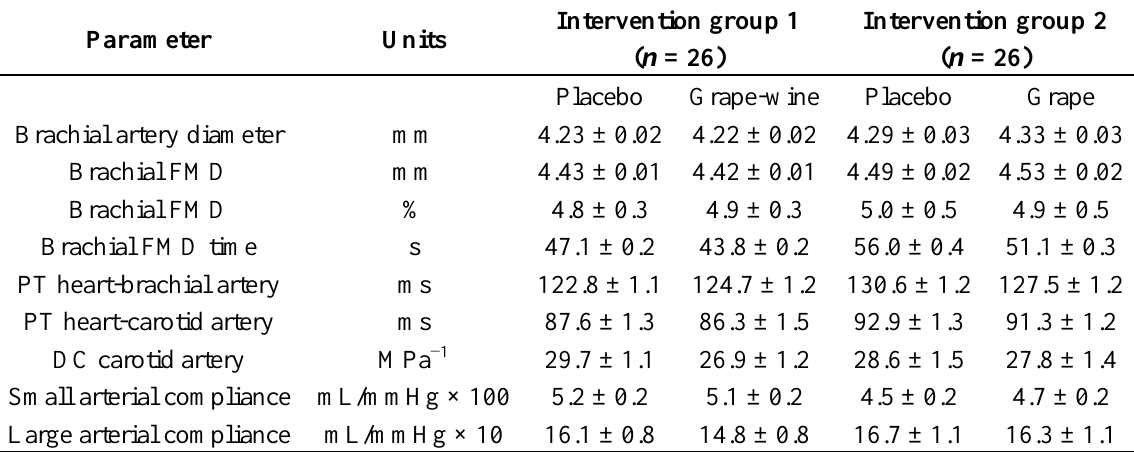
Table 2. The effect of grape-wine extract and grape extract on systemic, regional and local vessel